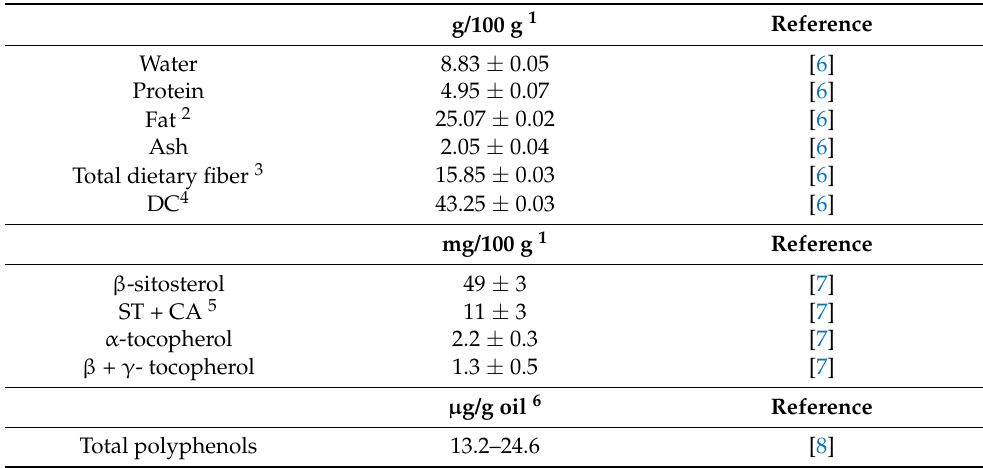
Table 1. Composition of Valencian tiger